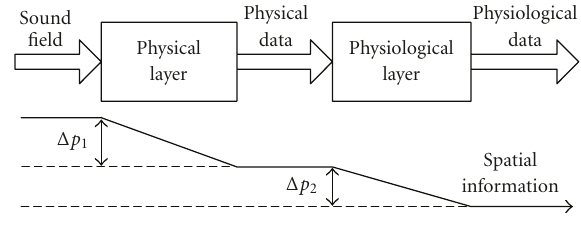
Figure 7: Spatial information loss.